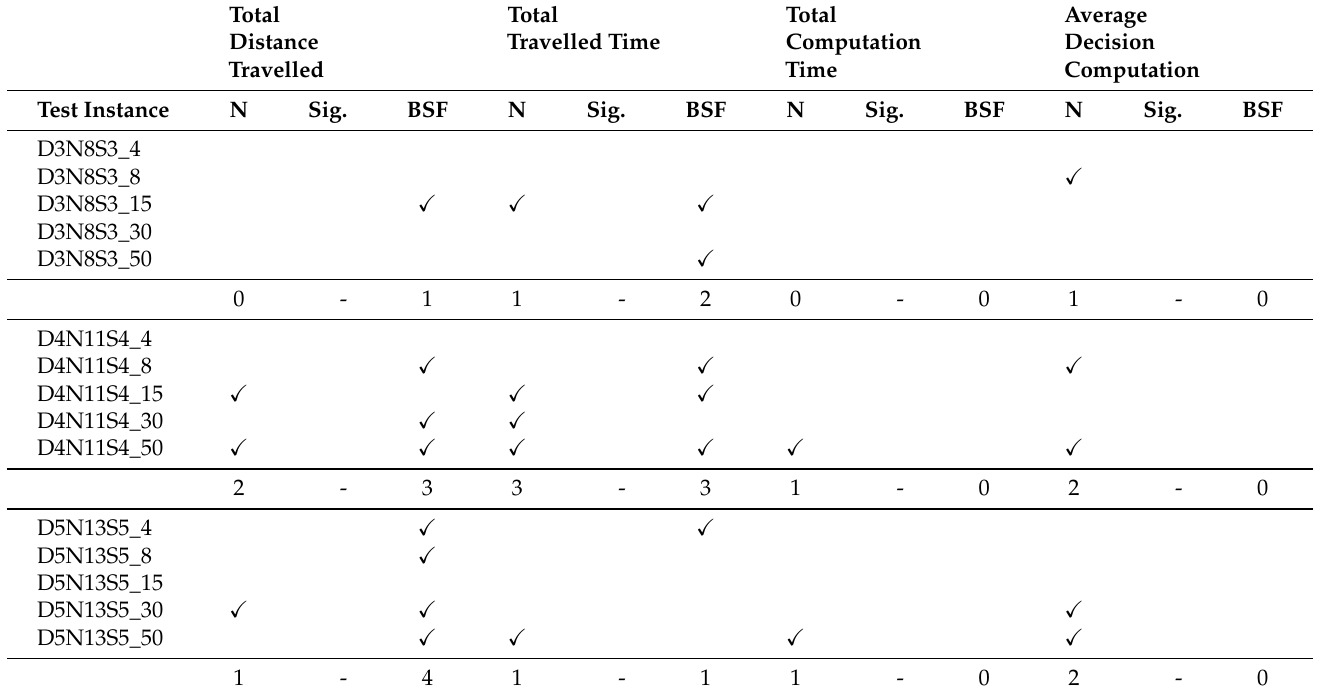
Table A7. PDS_RA performance with CPLEX application as base